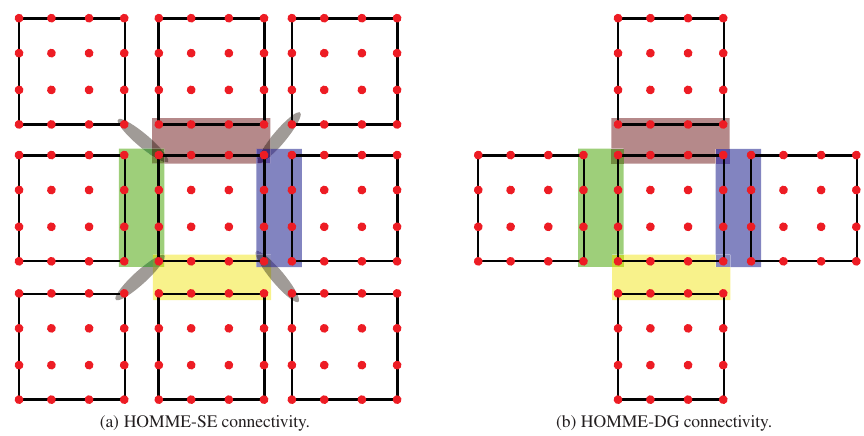
Figure 2. Connectivity in HOMME-SE (a) and HOMME-DG (b) . The DG version does not need to communicate vertex data, and thus connectivity to other processes is